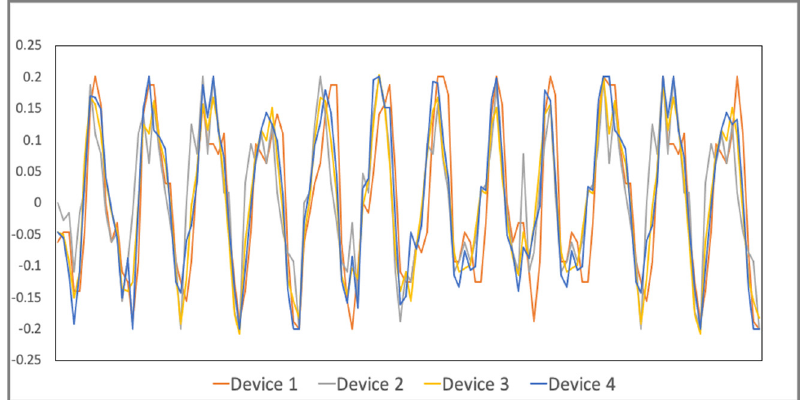
Figure 16. Acceleration monitoring of four sensor devices. Table 1. Standard deviation of accelerations at each timestamp.